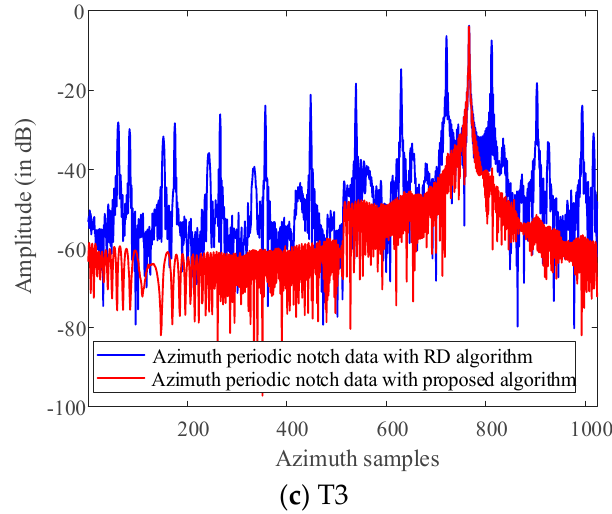
Figure 15. The comparison of slices of three-point targets with different scattering coefficients with RD algorithm and the algorithm proposed in this paper(dB).